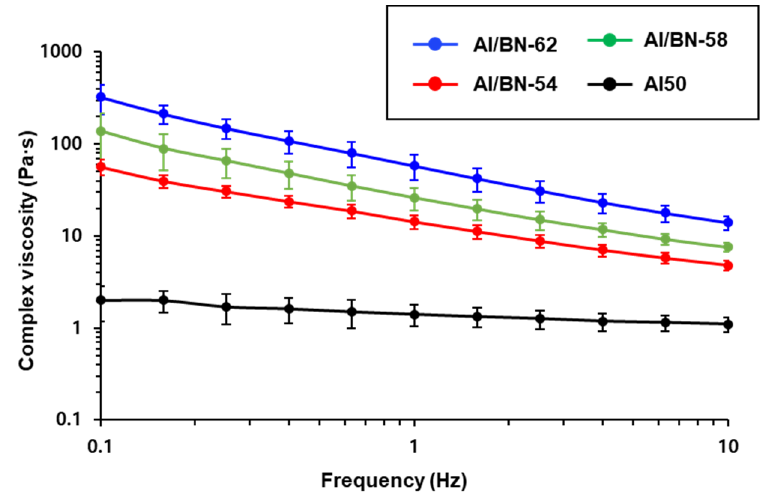
Figure 2. The frequency dependence of the complex viscosity of the Al50 and Al/BN composites. The effect of h-BN content on the thermal conductivity of the composites was investi- gated. Because of the anisotropic thermal conductivity of h-BN [6], both k x and k z of the 1 mm-thick composites were calculated using the thermal diffusivity ( α ) obtained through a laser flash method based on Equation (1) [27]. k = α × ρ × Cp (1) where ρ is density and Cp is specific heat. The k x and k z values of the composites increased with increasing h-BN content, and k x was more sensitive to the amount of h-BN than k z , as shown in Figure 3. Given that the test specimens were prepared by bar-coating, the h-BN fillers partially aligned in a parallel direction and thus, k x was higher than k z [4,28–31]. The k x and k z values of the Al/BN-62 composite reached 1.62 ± 0.04 Wm − 1 K − 1 and 0.86 ± 0.05 Wm − 1 K − 1 , respectively.